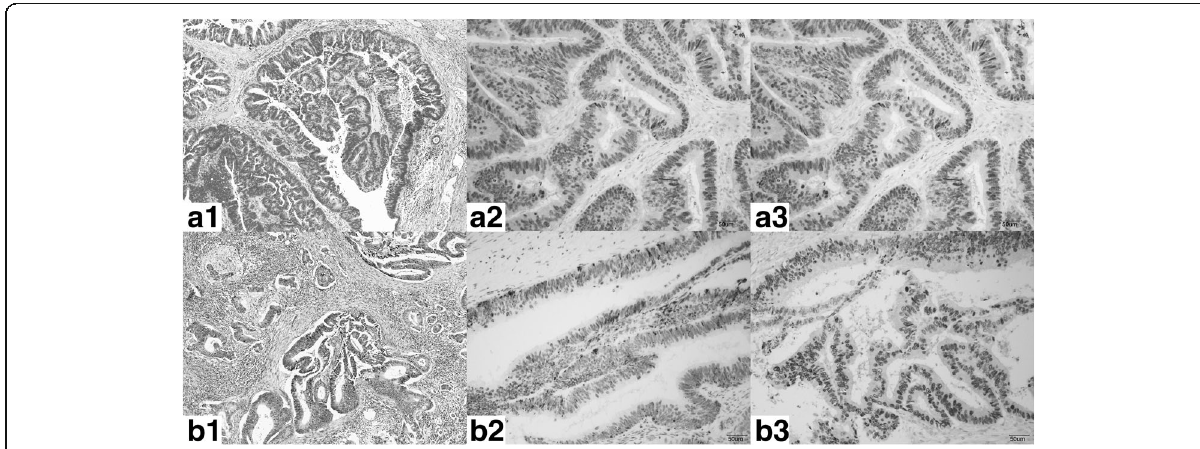
Fig. 2 Histological findings and immunohistochemical studies. a Specimens of the lung tumor. b Specimens of the rectal lesion; 1. hematoxylin-eosin stain; 2. Napsin A expression (monoclonal antibody IP64); 3. TTF-1 expression (monoclonal antibody SPT24). Hypercolumnar, atypical, papillary-tubular cells proliferated and were histologically diagnosed as adenocarcinoma ( a1 , b1 ). Of both the lung specimens and the rectal specimen, some tumor cells contained regions that were be positive for napsin A regardless of the staining method ( a2 , b2 ). Almost all the tumor cells of both specimens were positive for TTF-1 ( a3 , b3